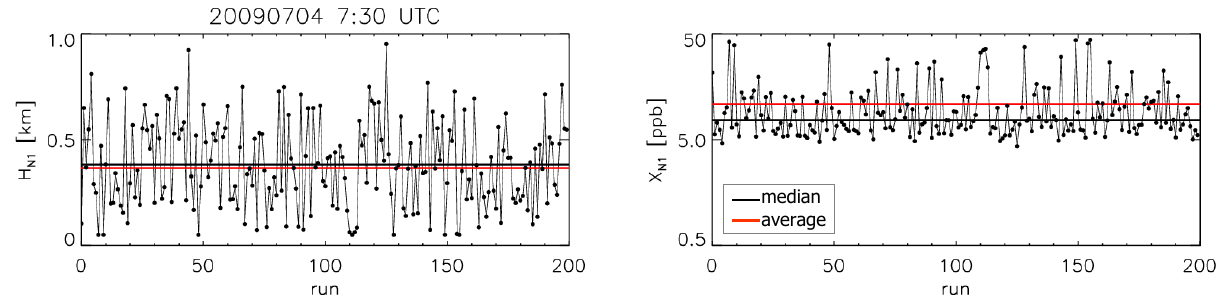
Fig. 5. Examples of the ensemble of 200 retrievals of the NO 2 layer height (left) and of the NO 2 volume mixing ratio (right). Note that the right plot has a logarithmic scale on the y-axis. This example demonstrates that although the ensemble average and median of H N 1 differ by only a small amount (4%), which indicates that the distribution of H N 1 is almost symmetric, the corresponding ensemble of X N 1 can be highly asymmetric, and consequently have a large difference between median and average (42%). For this reason, the median is used for the volume mixing ratio, see also Fig.